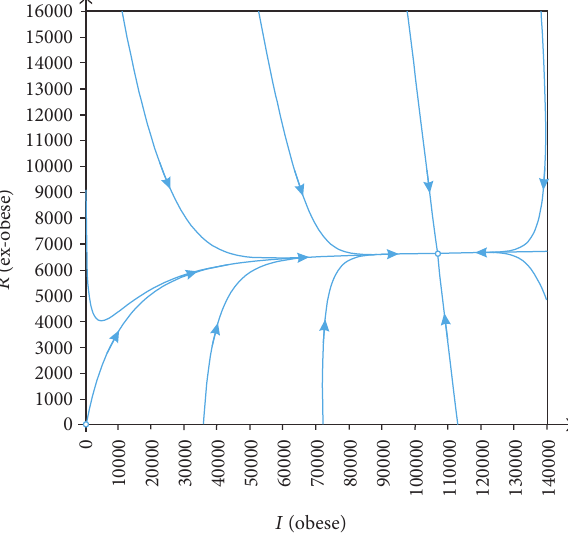
Figure 7: Phase portrait of system (6) (case 𝜖 = 0 ), for the value = 0.8 obtained by considering 𝛽 = 3.39 × 10 −7 . 𝑅 0